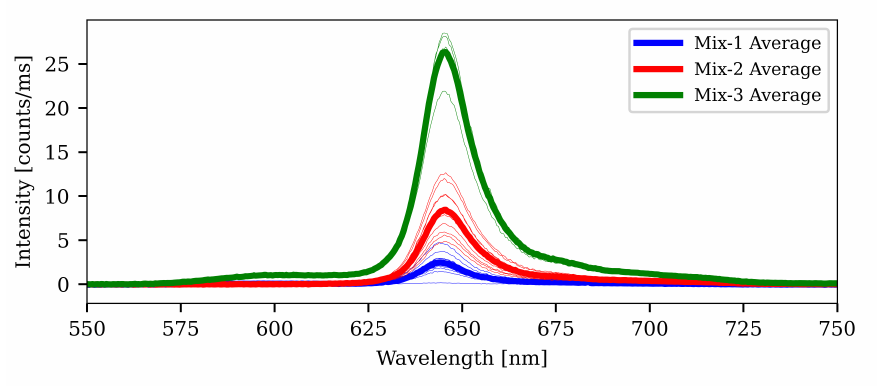
Figure 10. Intensities measured from the different sensors manufactured. All sensors had a concen- tration of PtOEP of 4.16mM. The ones made with Mix-1 were the worst of the lot. This is due to the fact that the solvent (acetone) does not provide a good solubility of PtOEP. The result is that PtOEP aggregates into clumps and self-quenching occur. Mix-2 sensors were based on a better solvent (Acetone + TCE), and the intensity is much improved. In that particular solvent, PtOEP can be loaded quite heavily (up to 11 mM according to our measurements). In Mix-3, the added C545T acts as a “light-harvester” and effectively increases the absorption cross-section of the PtOEP.